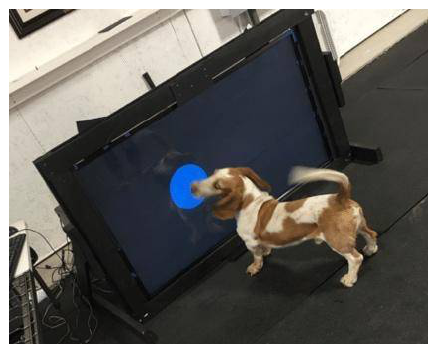
Figure 7. Dog training to click on points on a touchscreen interface [8].